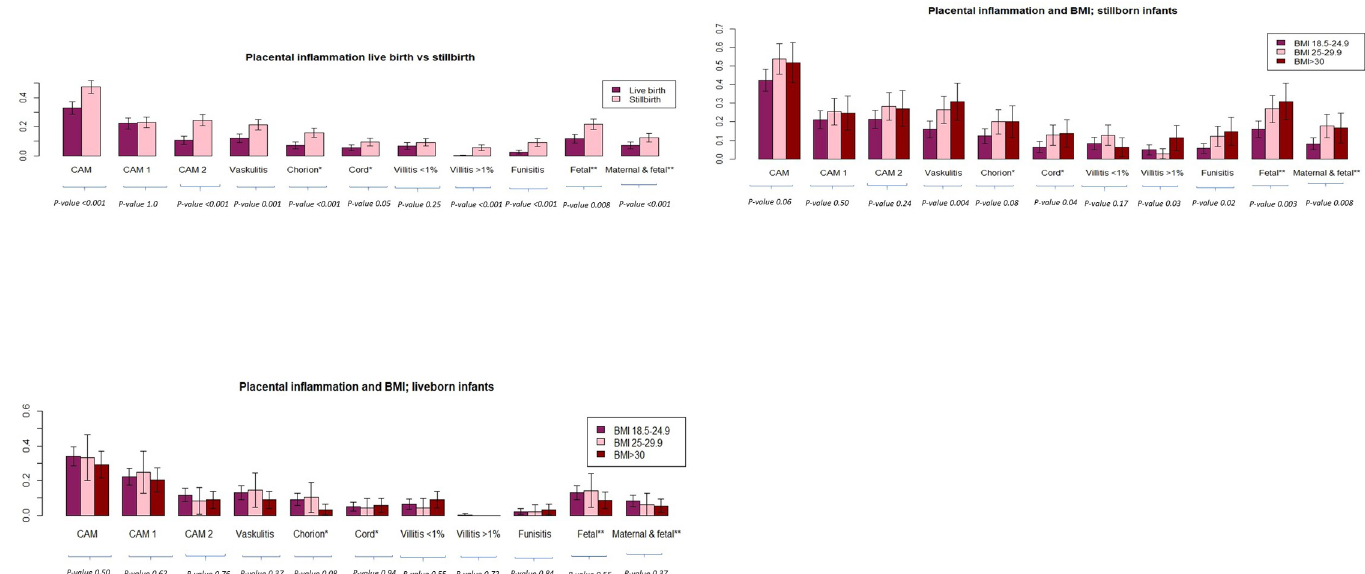
Fig 2. a. Placental inflammatory lesions compared between term pregnancies with live born infants and term pregnancies complicated by stillbirth. CAM– chorioamnionitis, * —vasculitis, ** —inflammatory response. b. Placental inflammatory lesions from term pregnancies complicated by stillbirth, divided by maternal pre- pregnancy BMI. Chi-square test for multiple proportions was used to evaluate significant differences. CAM–chorioamnionitis, * —vasculitis, ** —inflammatory response. c. Placental inflammatory lesions from term pregnancies with live born infants, divided by maternal pre-pregnancy BMI. Chi-square test for multiple proportions was used to evaluate significant differences. CAM–chorioamnionitis, * —vasculitis, ** —inflammatory response.